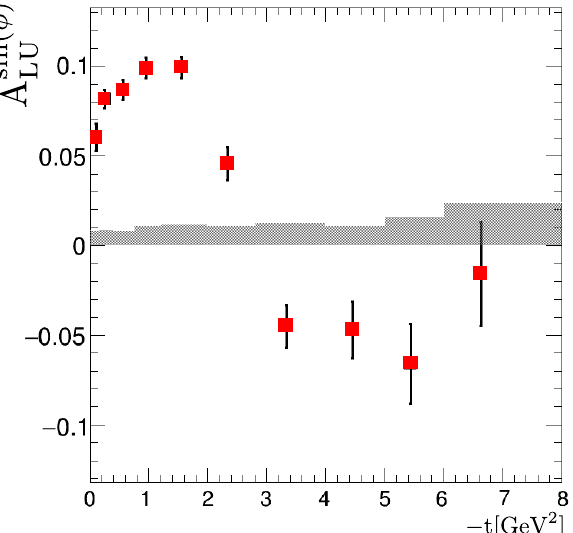
t measured with − t is 8.8 GeV 2 . − ≈